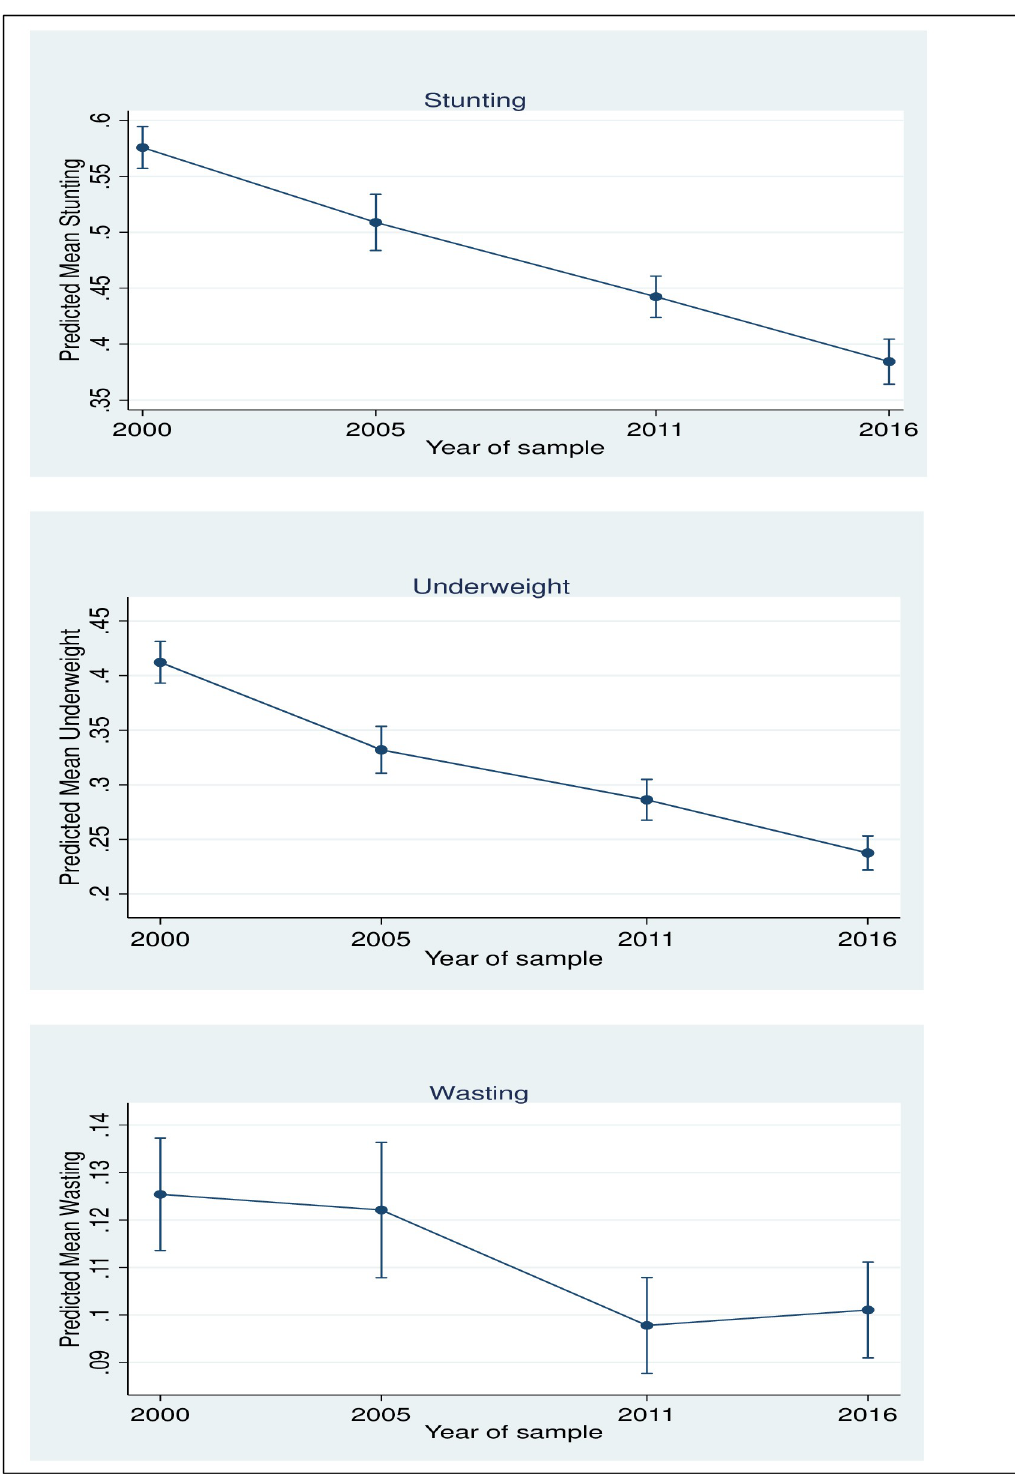
Fig 1. Predicted mean of CGF indicators among under-5 children in Ethiopia.